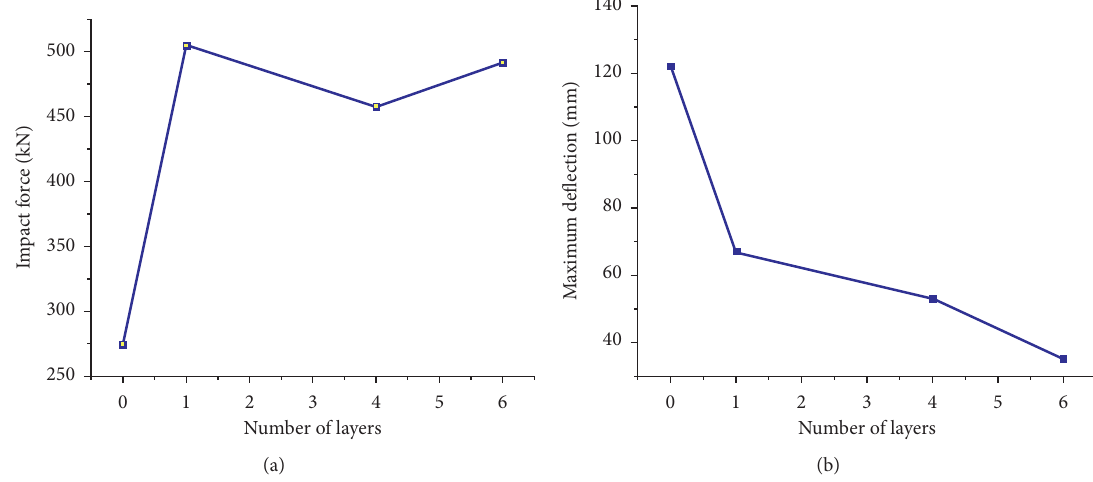
Figure 19: (a) Effect of CFRP layers on a maximum deflection of components. (b) Effect of CFRP layers on impact force of